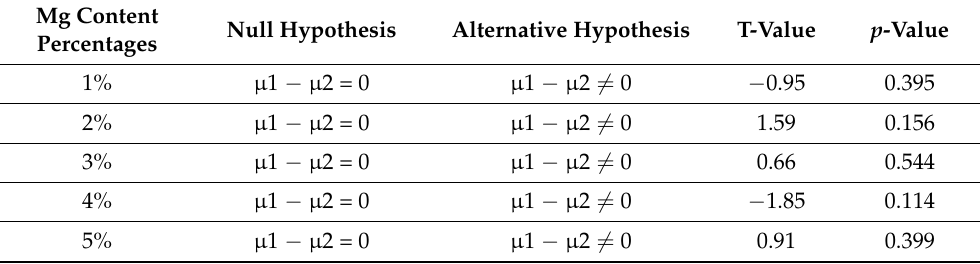
Table 8. The results of two-sample t-test for the electrical conductivity